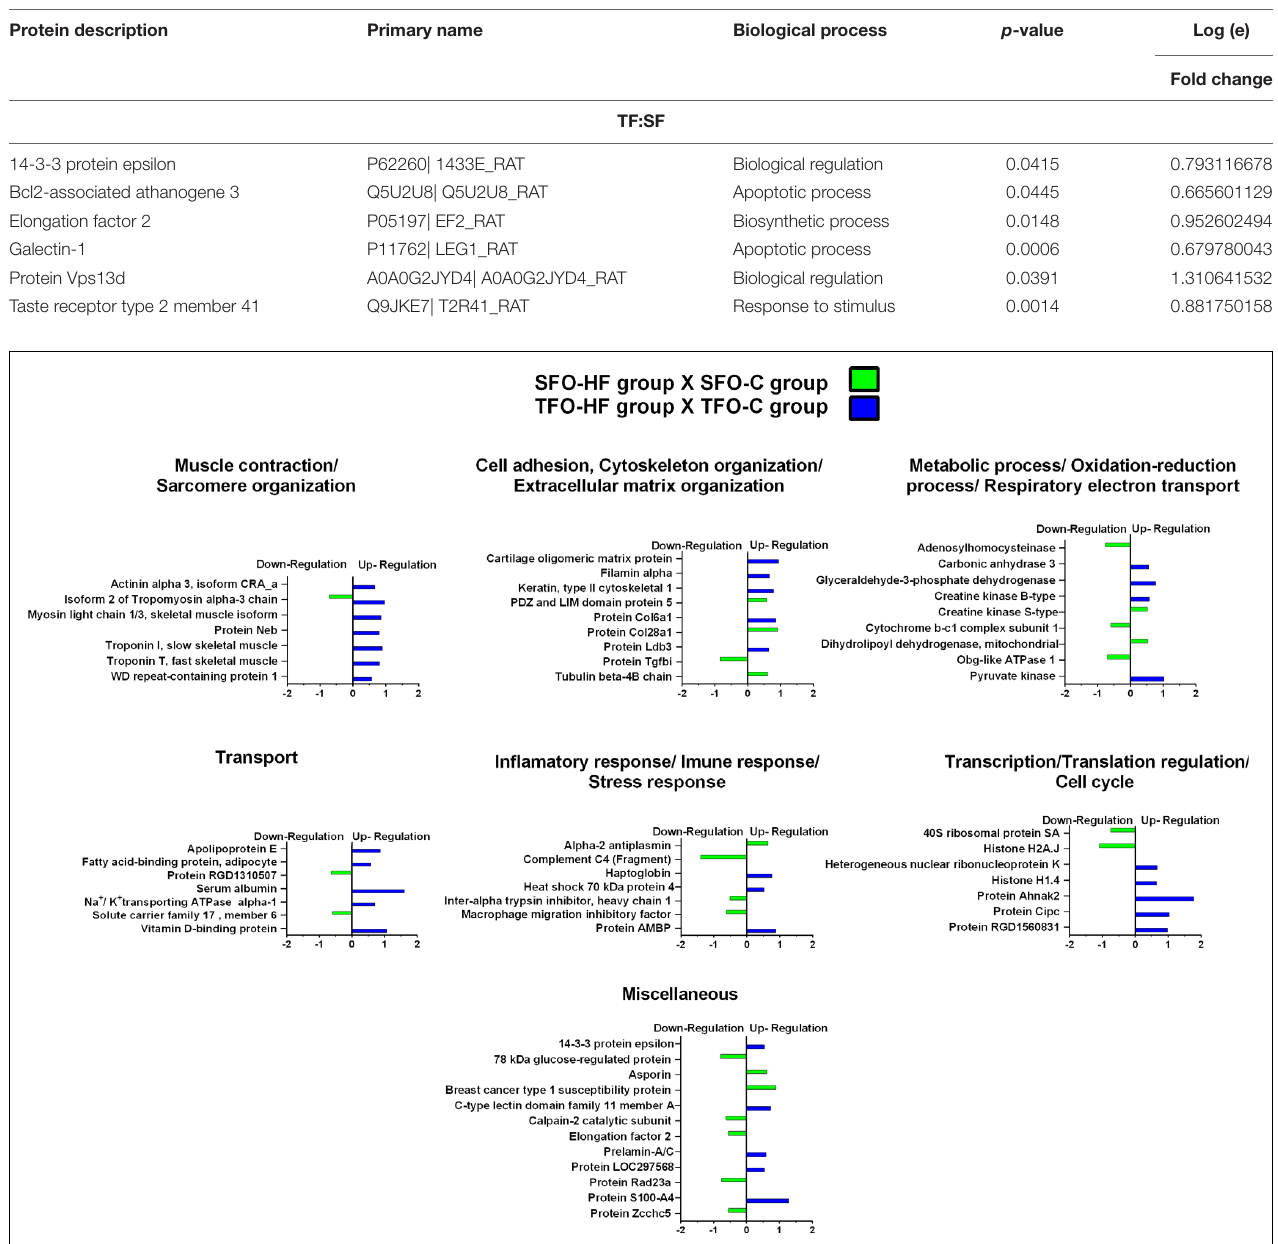
FIGURE 5 | High-fat diet effects on tendon proteome of the offspring. Histogram of protein abundance levels from intergroup analysis considering only proteins with down-regulation and up-regulation ( p ≤ 0.05), with a ln(fold change) of at least ( ≥ ) 0.5. SFO-HF, offspring from sedentary fathers exposed to high-fat diet; SFO-C, offspring from sedentary fathers exposed to control diet; TFO-HF, offspring from trained fathers exposed to a high-fat diet; TFO-C, offspring from trained fathers exposed to control diet. The X -axis represents the natural logarithm of the ratio between the treatments ( green: SFO-HF:SFO-C ratio; blue: TFO-HF:TFO-C ratio) . All altered proteins are grouped according to their biologic process as noted in Gen Ontology (GO). The proteins were considered reliably identified only if presenting an FDR < 1% and at least two matching peptides. Supplementary Data 3 shows detailed information about each protein outlined in this